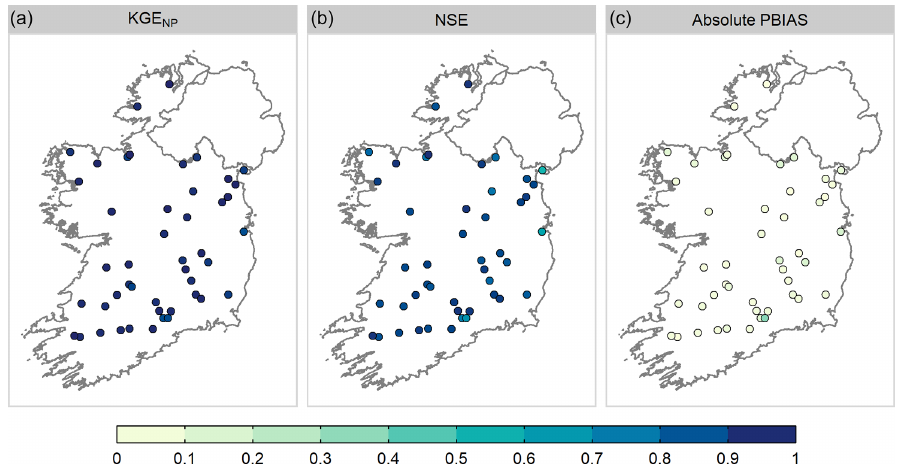
Figure 2. GR4J model performance over the complete period (1993–2017) as measured by KGE NP (a) , NSE (b) , and absolute PBIAS (c) .